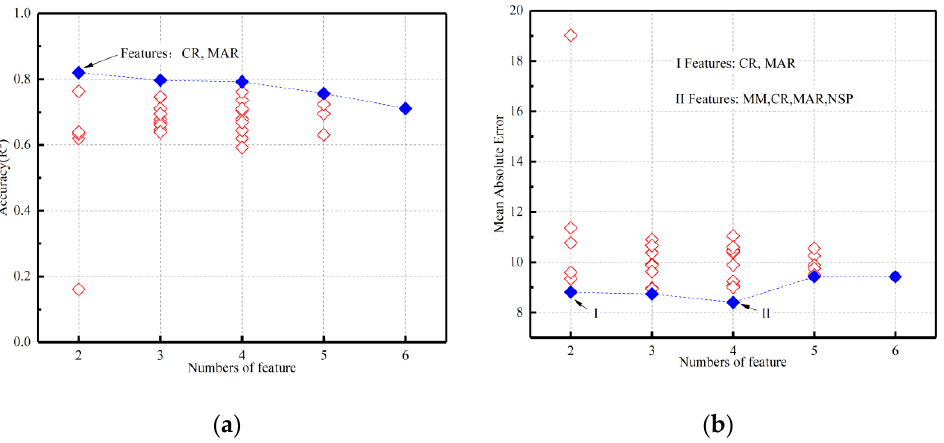
Figure 9. ( a ) R 2 > 0 results of different RF algorithm feature combinations with 100 trainings and ( b ) the MAE results of different RF algorithm feature combinations with 100 trainings.